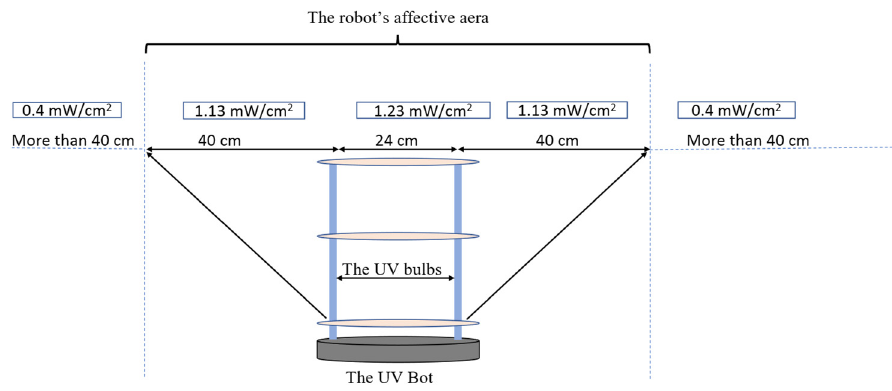
Figure 9. The UVBot effective distance and targeted disinfection area.